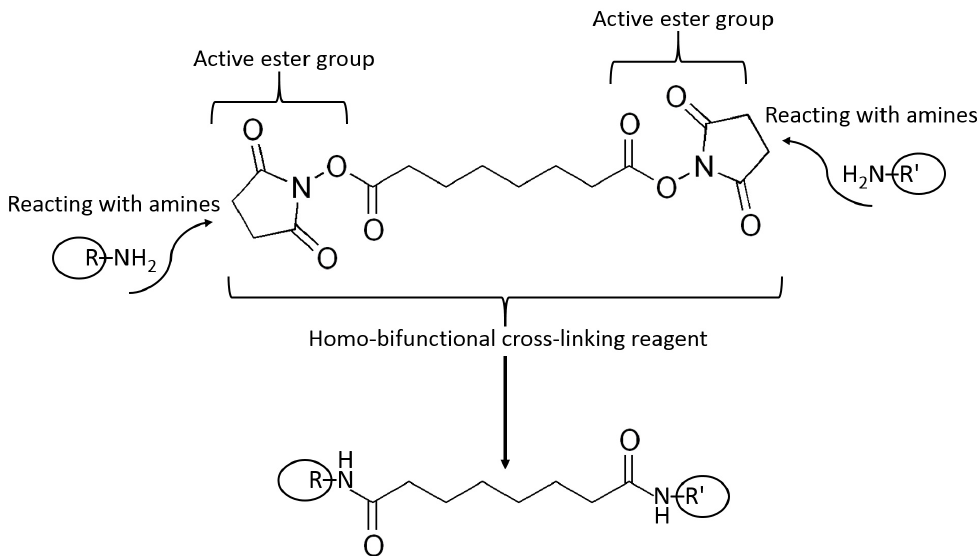
Figure 10. A homobifunctional cross-linker containing two active ester functions used to bind biomolecules by reacting with their amino groups and producing amido bonds. Note the long and flexible spacer between the reacting groups. Many other similar cross-linkers are available with various structures and length of the spacer connecting the reacting